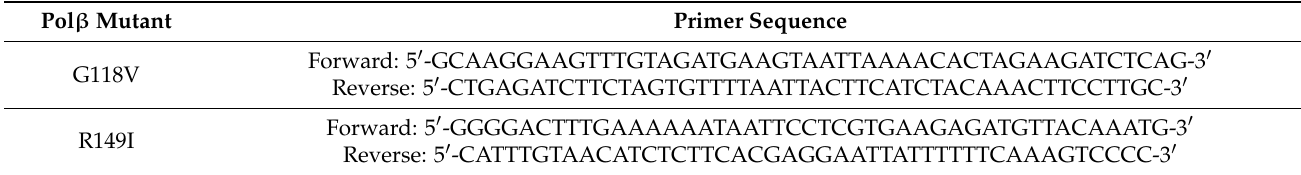
Table 5. Primer sequences used for site-directed mutagenesis. Primer Sequence